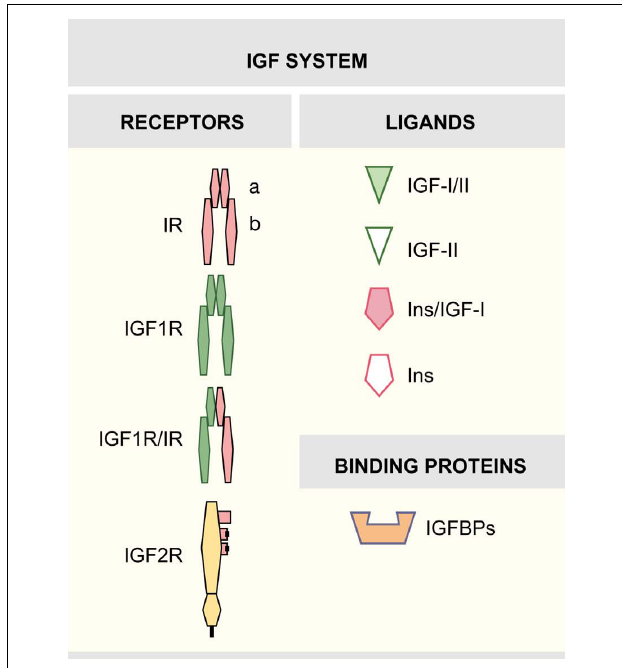
FIGURE 1 | Insulin-like growth factor